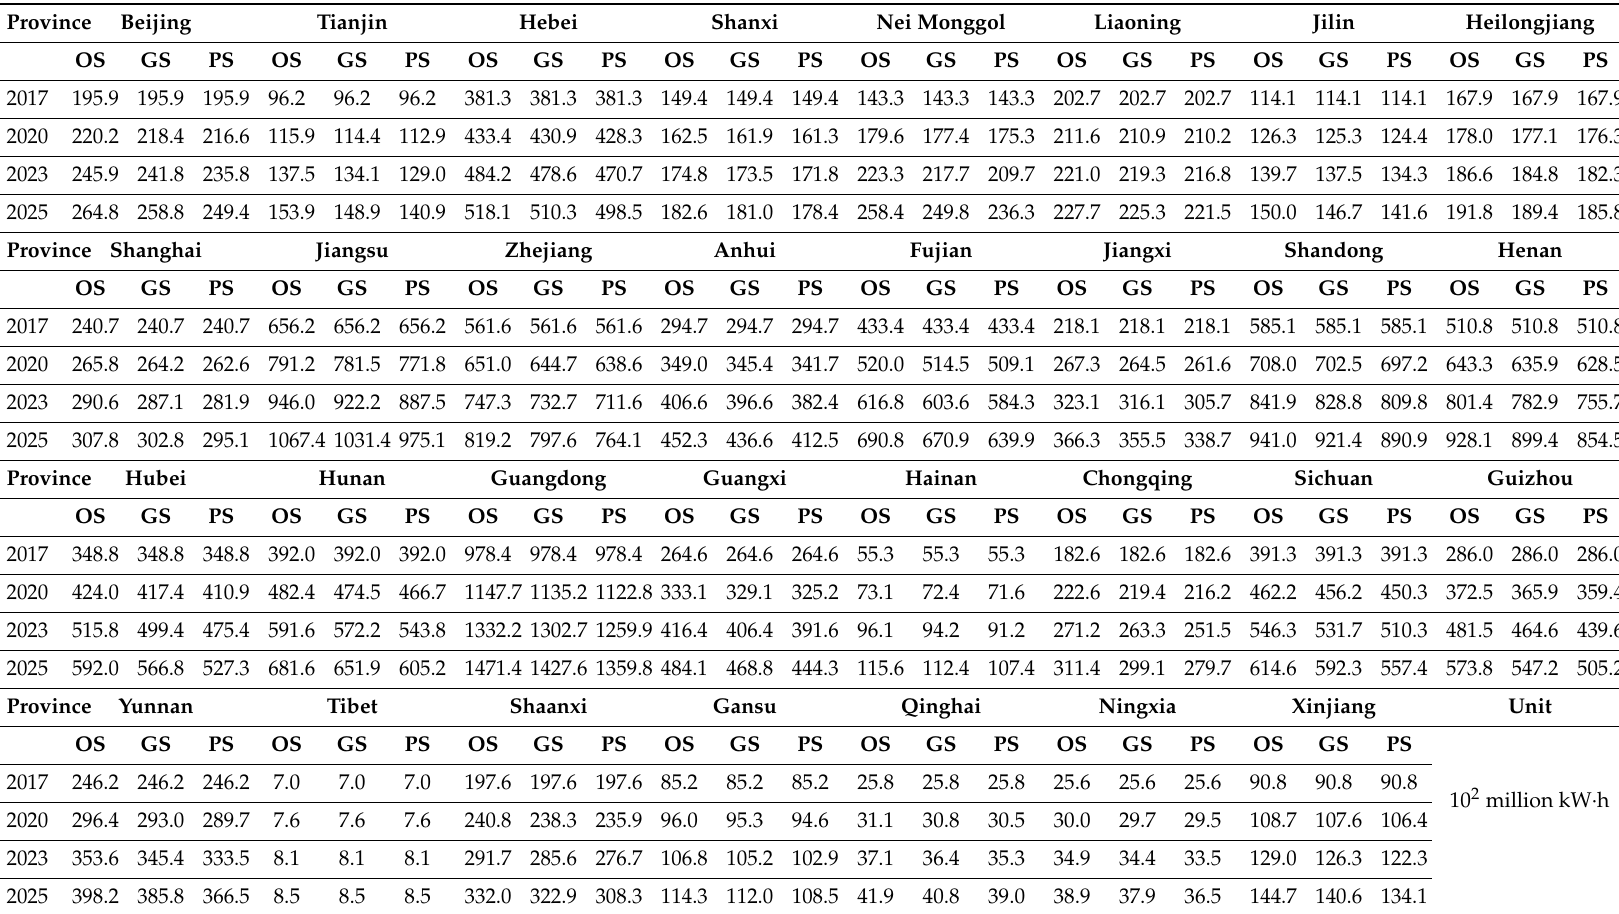
Table A5. Regional household electricity consumption under di ff erent